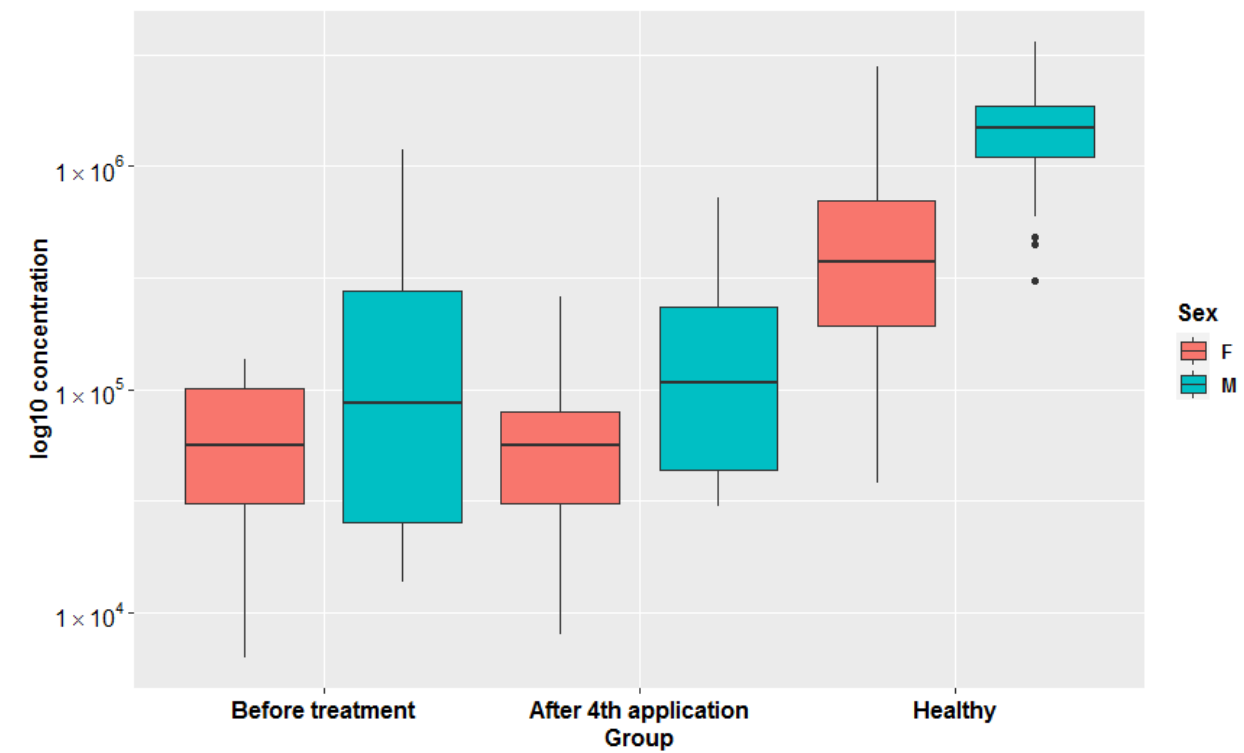
Figure 5. Box-plots representing log10 transformed creatinine concentrations in all three groups (before treatment, after 4th application, healthy) in females and males separately. Original concentrations are presented in Figure S9.